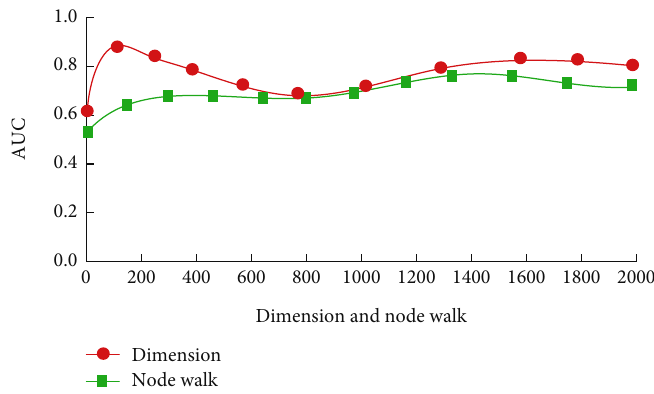
Figure 4: In fl uence of di ff erent embedding dimensions and node routing on AUC.